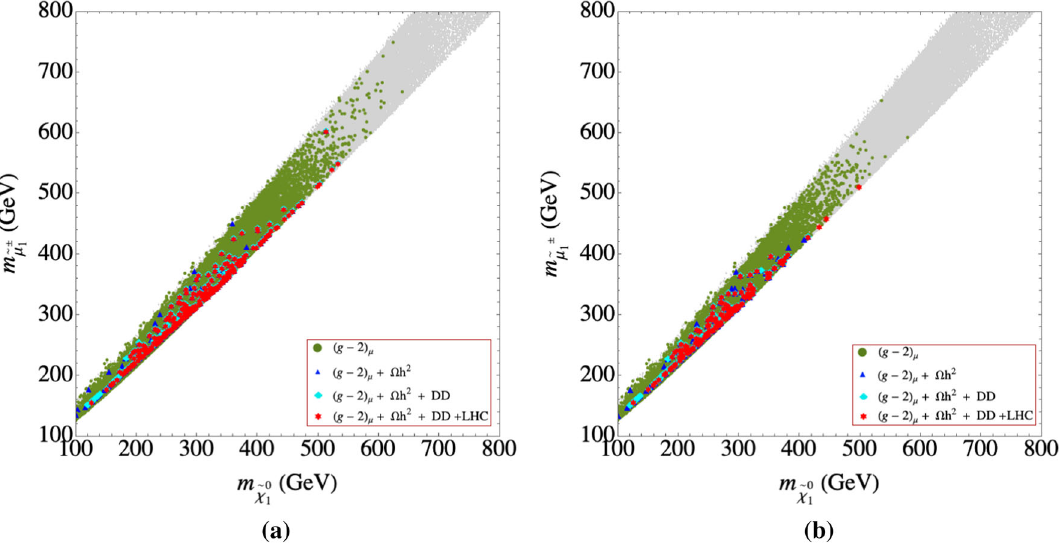
− m plane for the ˜ l ± -coannihilation Case-L (current (left) and anticipated future limits ˜ χ 0 1 1